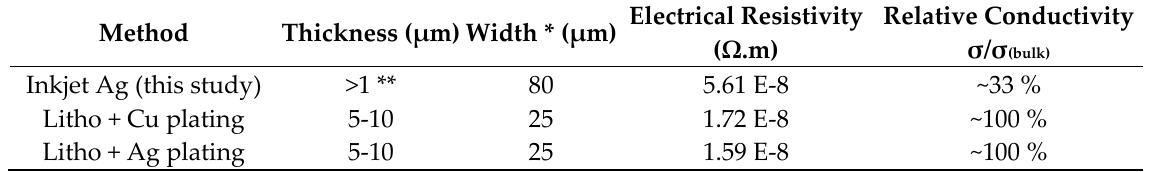
Table 1. Material properties of the inkjet printed RDLs in comparison to the conventional